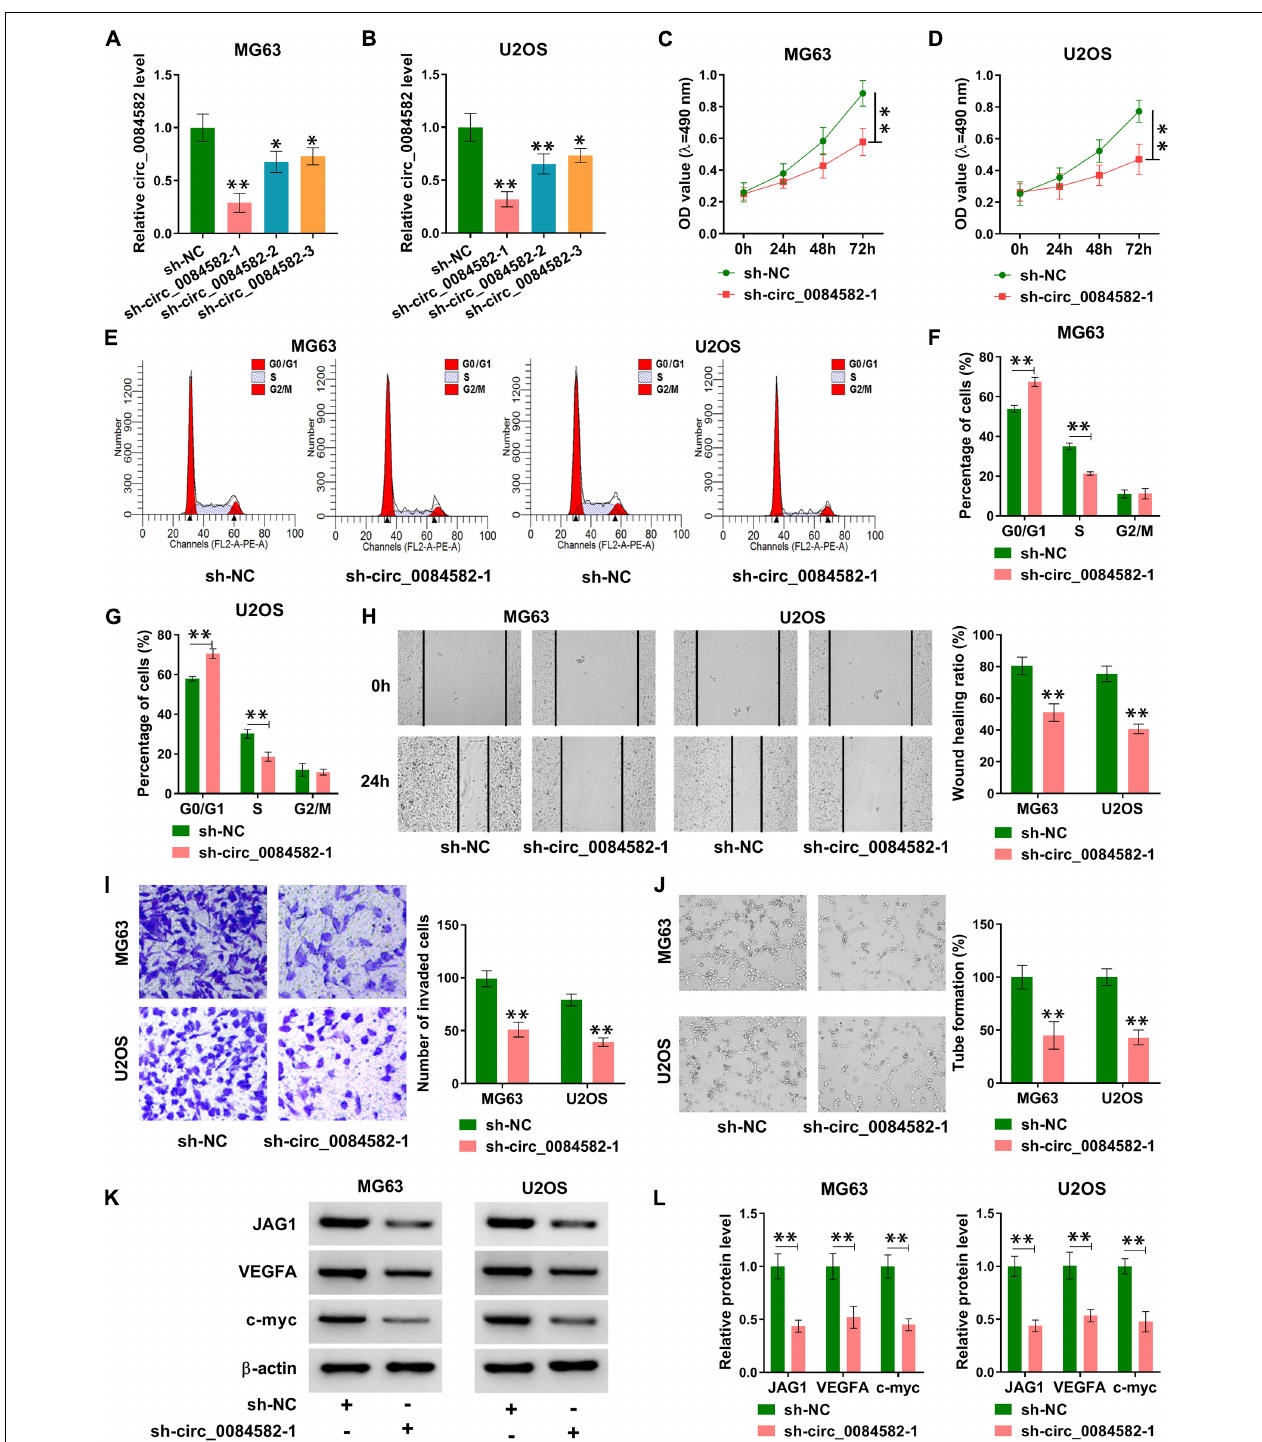
FIGURE 2 | Knockdown of circ_0084582 impedes cell proliferation, cell cycle progression, migration, invasion, and angiopoiesis in OS cells. (A,B) The knockdown effects of sh-circ_0084582-1, sh-circ_0084582-2, and sh-circ_0084582-3 on the circ_0084582 expression are determined using qRT-PCR in OS cells. (C,D) MTT was used for detecting cell proliferation after MG63 and U2OS cells were transfected with sh-circ_0084582-1 or sh-NC. (E–G) Flow cytometry was used for analyzing the progression of cell cycle. (H,I) Transwell assay was used for evaluating cell migration (H) and invasion (I) . (J) Tube formation assay was used for assessing angiopoiesis. (K,L) Western blot was used for assaying the protein levels of JAG1, VEGFA, and c-myc. All experiments were performed with three biological replications. ∗ P < 0.05, ∗∗ P < 0.01.